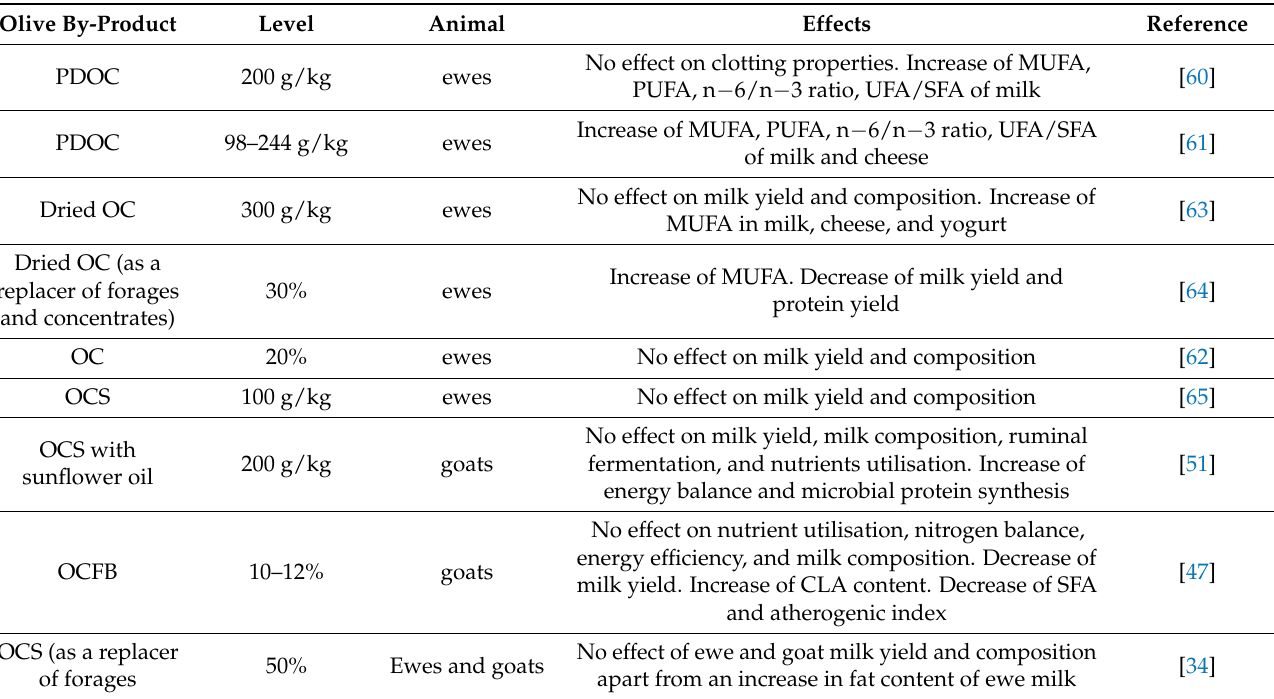
Table 2. The effects of olive by-products dietary supplementation on milk products of